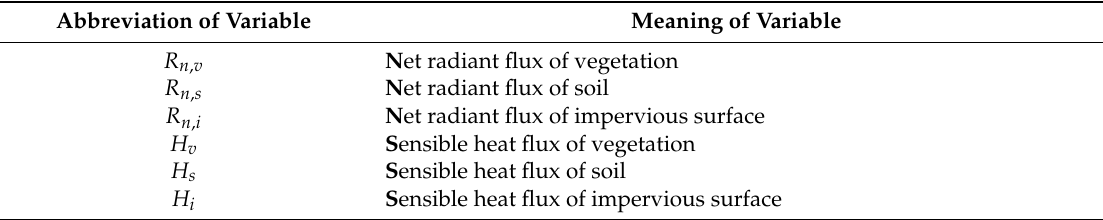
Table A1. List of variables used in the